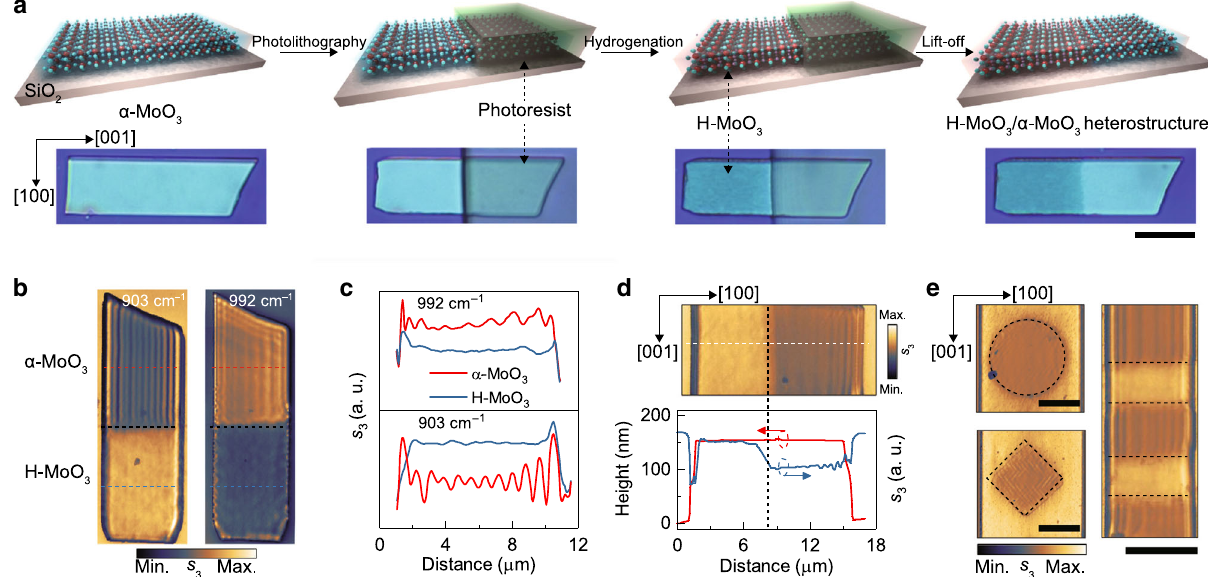
Fig. 5 Spatially controllable switching of PhPs by selective hydrogenation. a Illustrations of the spatially selective hydrogen intercalation process, and corresponding microphotographs of a typical MoO 3 fl ake. Scale bar = 10 μ m. b Amplitude images of an H-MoO 3 / α -MoO 3 in-plane heterostructure (along the [001] direction) at 903 and 992 cm − 1 . The black dashed line indicates the hydrogenation boundary. c Line traces extracted from amplitude images (red and blue dashed lines) in b . d Amplitude image (893 cm − 1 ) and corresponding amplitude and height line scans (white dashed line) of an in-plane heterostructure (along the [100] direction). e Amplitude images of heterostructures with various geometries. Scale bars = 5 μ